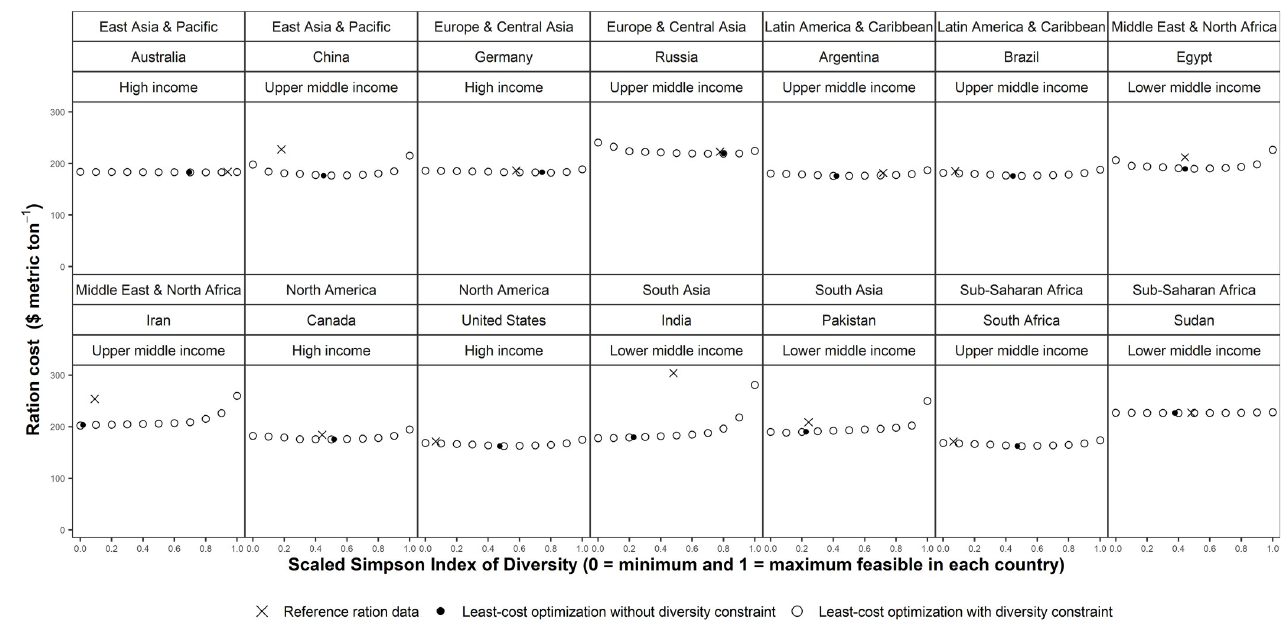
Fig 1. Feed ration cost for different levels of feed ration diversity. Markers labelled ‘Reference ration data’ are country-specific commodity mixes based on the share of each cereal grain commodity in the cereal grain feed rations [5]. Markers labelled ‘Least-cost optimization without diversity constraint’ are simulated rations from the programming model that solves for the least-cost combination of commodities by mass that maintains at least the reference ration nutrient content with no explicit constraint on the level of diversity. Markers labelled ‘Least-cost optimization with diversity constraint’ are simulated rations from the programming model that solves for the least-cost combination of commodities by mass that maintains at least the reference ration nutrient content at specific levels of the Simpson Index of Diversity. Higher values of the Simpson Index indicate a more diverse feed ration. Prices described in Table 3. Scaled Simpson Index is computed using minimum and maximum feasible index value (Table 5). A zero value for the Scaled Simpson Index corresponds to the minimum feasible Simpson Index value in the model for that country. A value of one for the Scaled Simpson Index corresponds to the minimum feasible Simpson Index value in the model for that